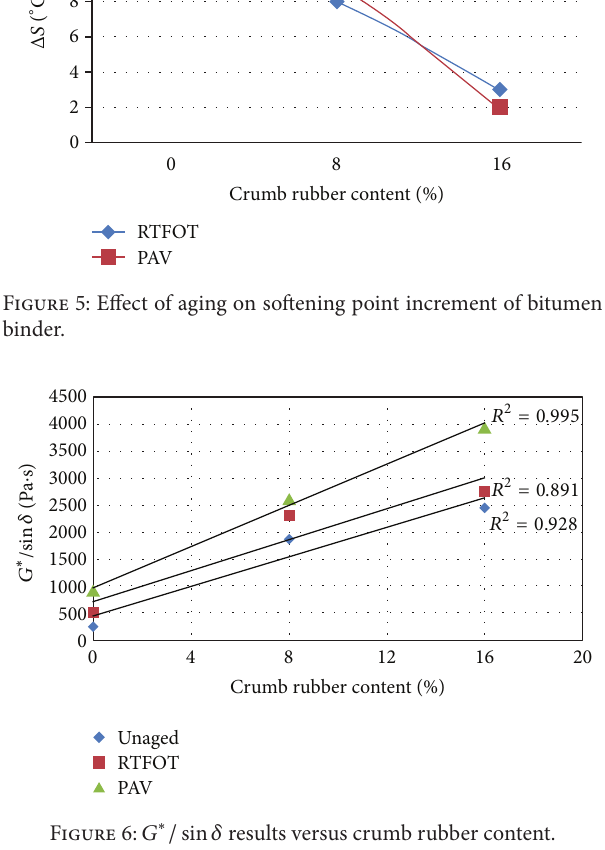
Figure 6: 𝐺 ∗ / sin 𝛿 results versus crumb rubber